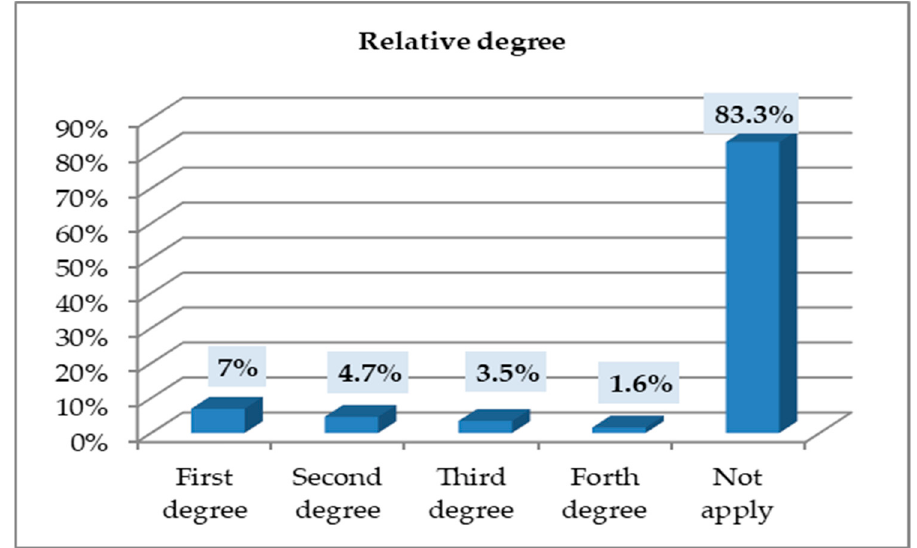
Figure 4. Frequency percentage of distribution of relationship degree.